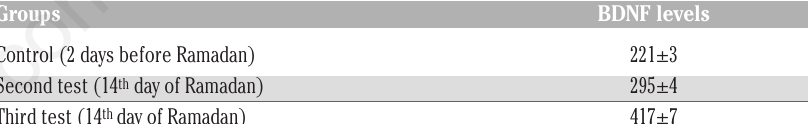
Table 1. Effect of fasting on brain-derived neurotrophic factor levels in the group of women only. All data are expressed as means±standard error of mean; P<0.05. Groups